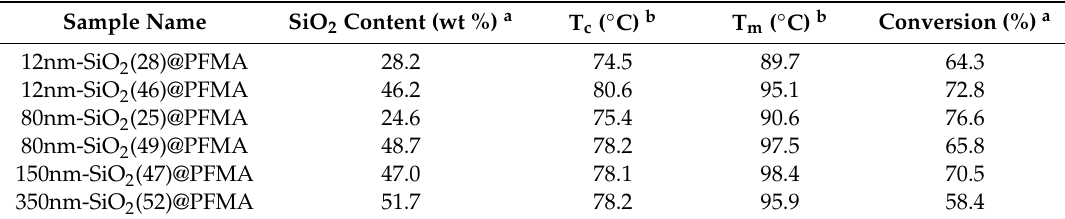
Table 1. Characterization of the SiO 2 @PFMA core-shell